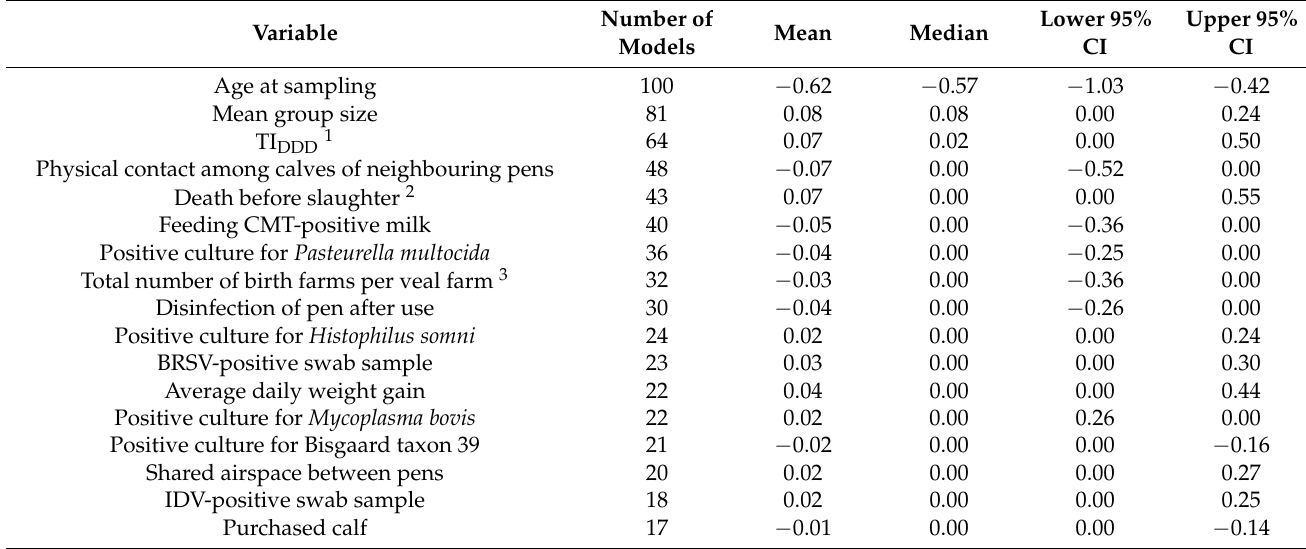
Table 4. Selection criteria from the elastic net variable selection algorithm from 100 iterations for variables associated with the detection of bovine coronavirus (BCoV) from nasopharygeal swab samples, as well as quality measurements of the selection process. Variables that occurred in more than 50 models and had a 95% confidence interval not crossing zero were selected for a final inferential